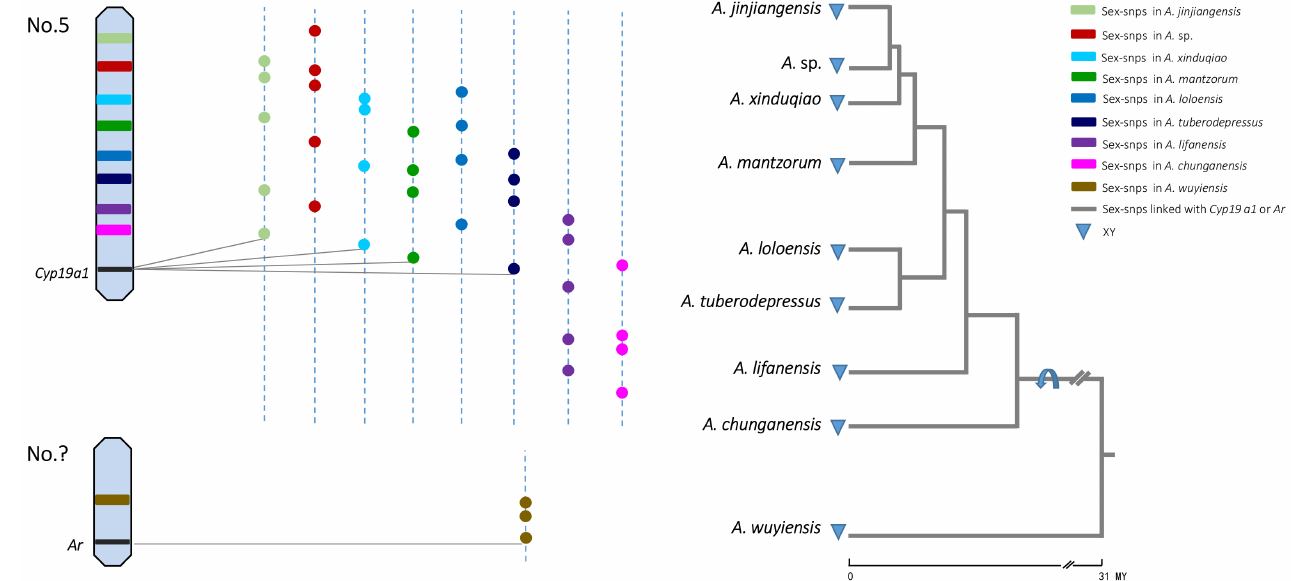
Figure 1. Sex chromosome turnover across nine torrent frog species. Sex-determination system and sex-chromosome identities come from both GBS and RAD-seq (see detail in Table S3) data. Two chromosome pairs harbor a different candidate gene for sex determination: one is chromosome 5 and the other is unknown. Blue arrow shows the branch on which the inferred turnover occurs based on the direct mapping analyses. The dotted lines represent the sex chromosome for each species, and colored dots show sex-linked SNPs of nine Amolops species. Sex-linked SNPs are randomly located and there is no shared XY site except one between alternate species pairs of A. xinduqiao and A. sp (the site is not shown here). The grey solid lines show some sex-linked SNPs for five species were mapped to Cyp19a1 and Ar genes, respectively. The tree topology was adapted using a combination of data from mitochondrial phylogenies by Lu et al. (2014) [45] and Zeng et al. (2020) [26], and